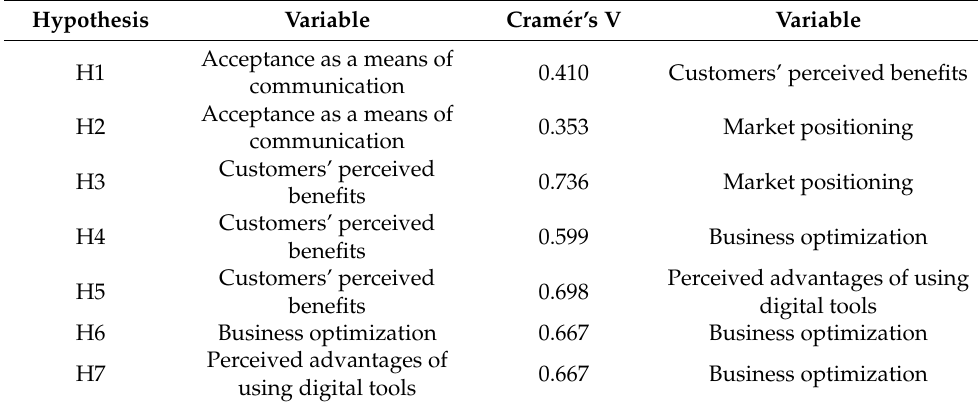
Table 7. Hypothesis testing between each pair of variables using Cram é r’s V.